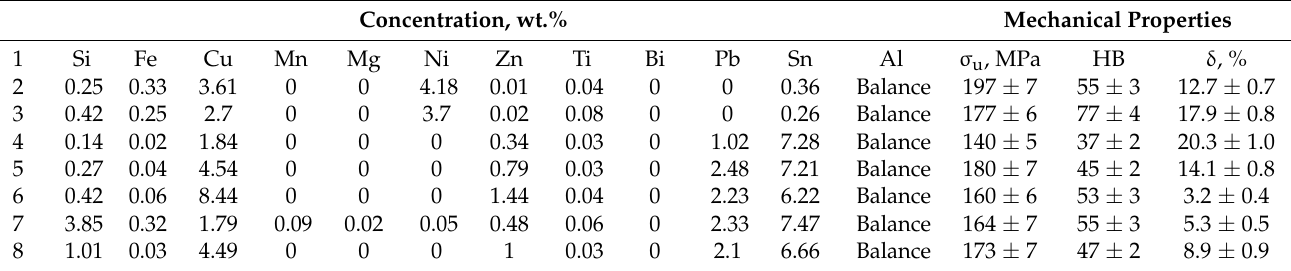
Table 4. Chemicalcompositioncombinationscorrespondingtomaximumandgoodmechanicalproperties. Concentration,